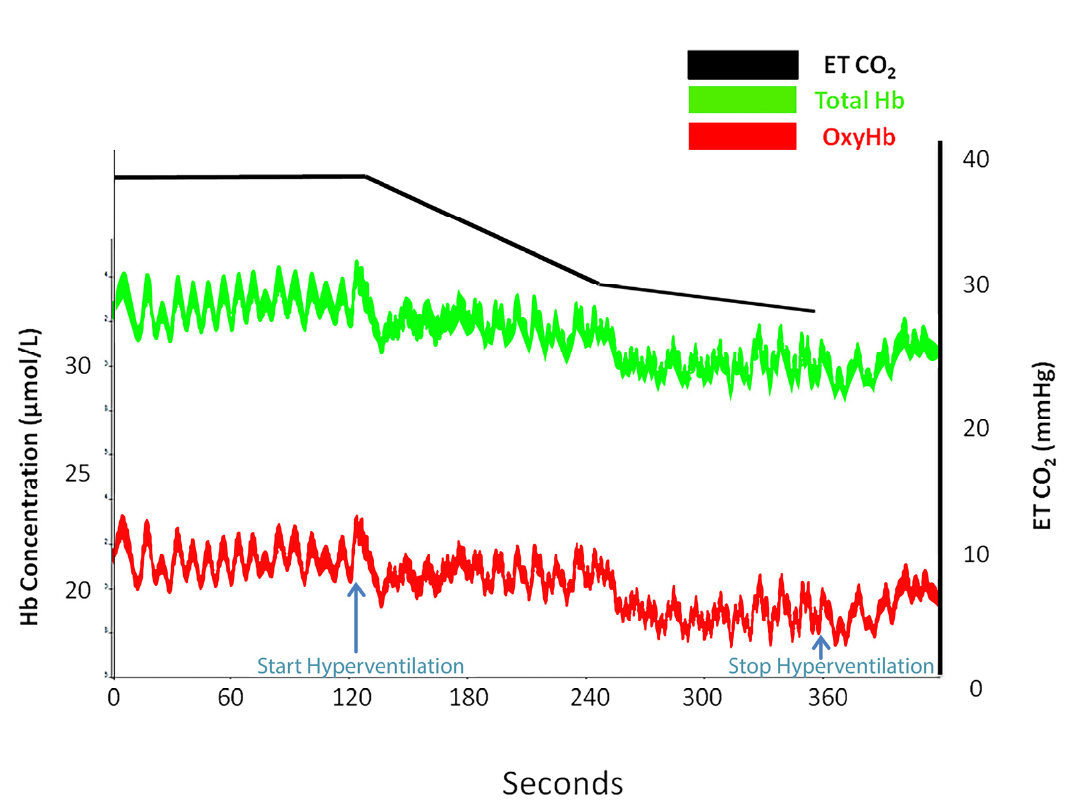
Figure 3. Total hemoglobin (tHb) trace (green), oxyhemoglobin trace (red), and end-tidal CO 2 trace (black) at baseline and during hyperventilation in the subject presented in Figure 2.